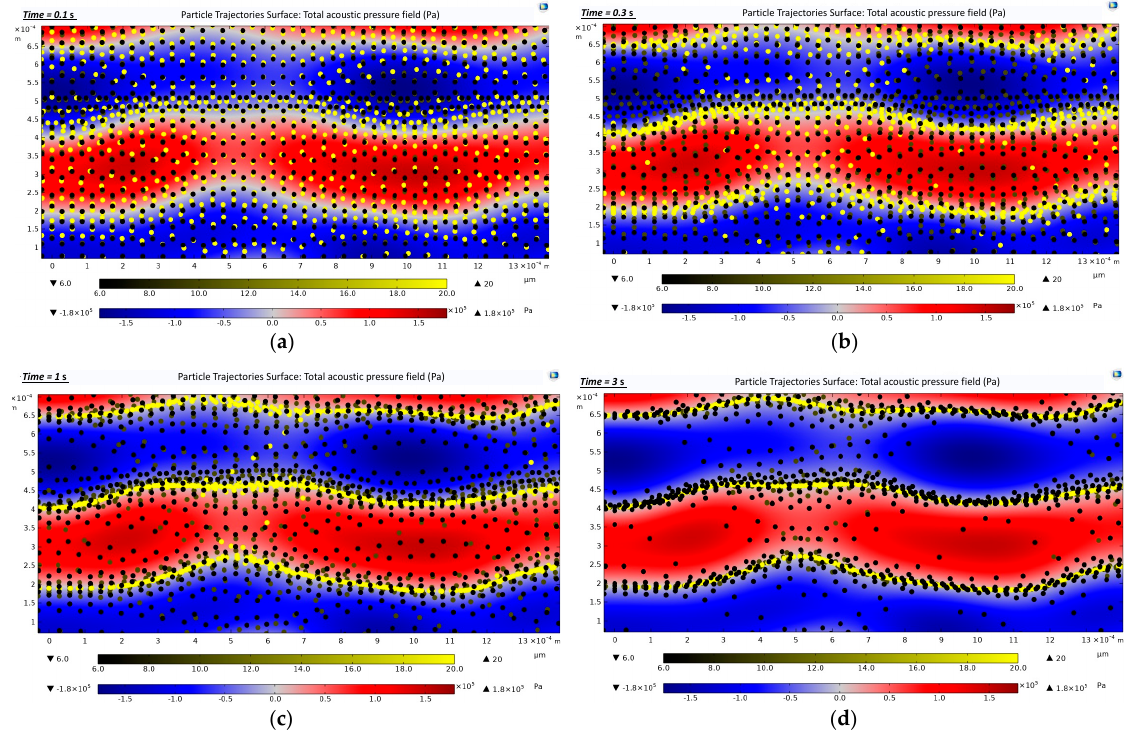
Figure 9. Distribution of the cells subjected to the acoustic pressure field along the straight rectangular section of the microchannel serving as an active separation in the hybrid device (zoom-in images that show three pressure nodal lines occurring in the straight rectangular section): ( a ) Cell trajectories at t = 0.1 s; ( b ) Cell trajectories at t = 0.3 s; ( c ) Cell trajectories at t = 1 s; ( d ) Cell trajectories at t = 3 s.